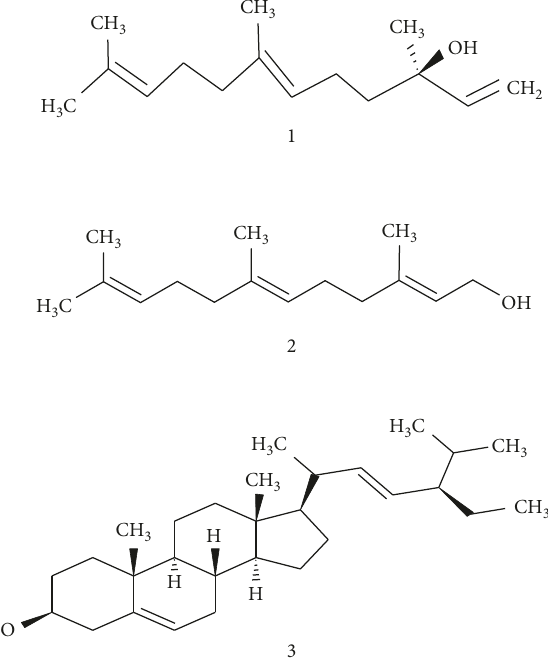
Figure 7: The active compounds nerolidol (1), farnesol (2), and stigmasterol (3) were isolated from the crude hexane extract of Salvia serotina